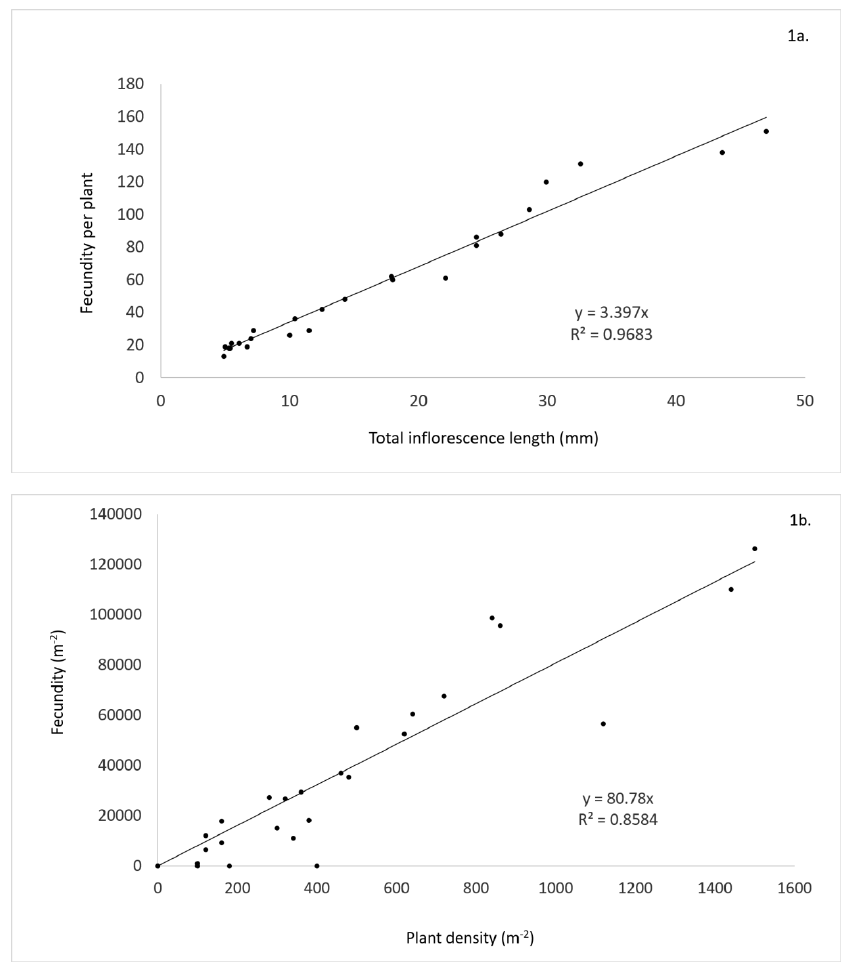
Figure 1. ( a ) Relationship between total inflorescence length and total seed production per barley grass plant. ( b ) Relationship between plant density and fecundity during 2017 within a legume pasture at Charles Sturt University campus, Wagga Wagga, NSW. Data are presented as functional two-parameter linear models fitted to total inflorescence length and total seeds produced per plant (Figure 1a, n = 25) and plant density and fecundity per metre (Figure 1b, n =